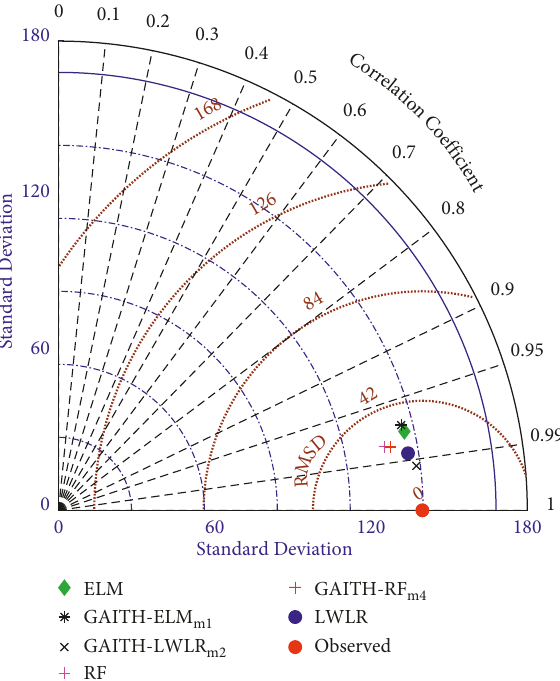
Figure 14: Improvement of the correlation of determination in the proposed models using the feature selection algorithm.